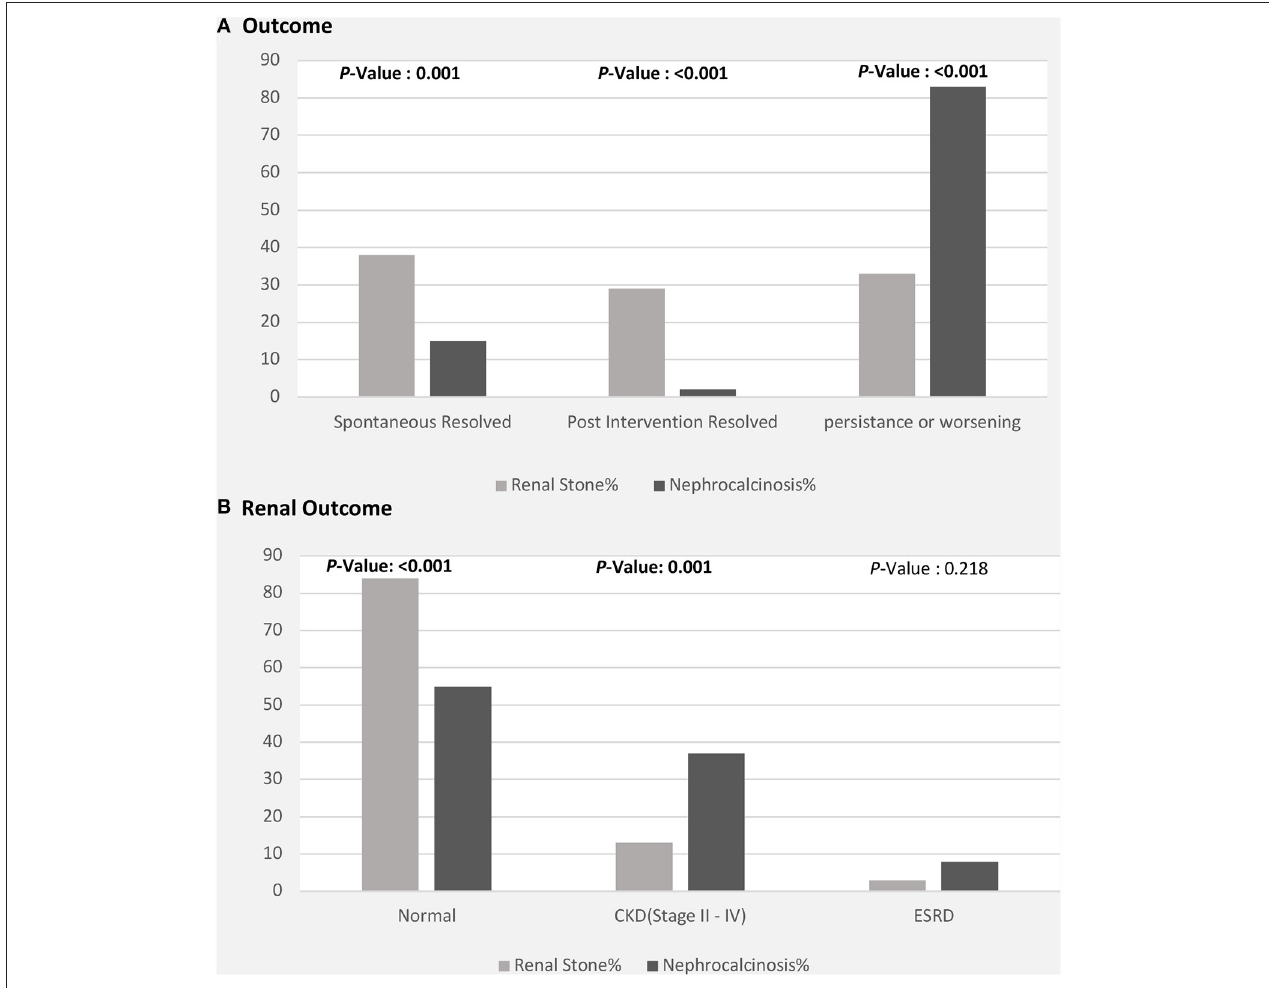
FIGURE 4 | Clinical outcomes among patients with nephrolithiasis/urolithiasis (renal stones) and nephrocalcinosis. CKD, chronic kidney disease; ESRD, end-stage renal disease. (A) Radiological outcome in children with nephrolithiasis and nephrocalcinosis. (B) Renal function outcome in children with nephrolithiasis and